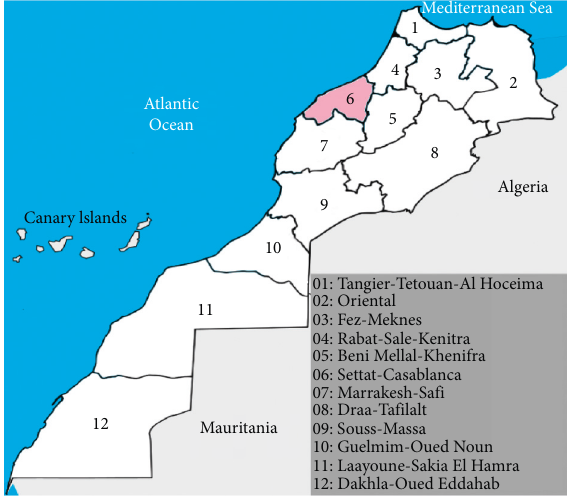
Figure 1: Map of Casablanca-Settat region in Morocco.